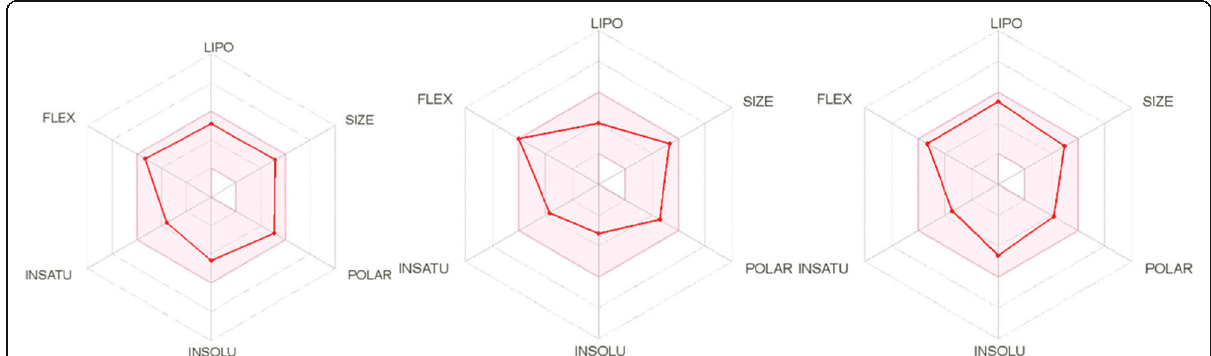
Fig. 3 The bioavailability radar for compounds 3, 13, and